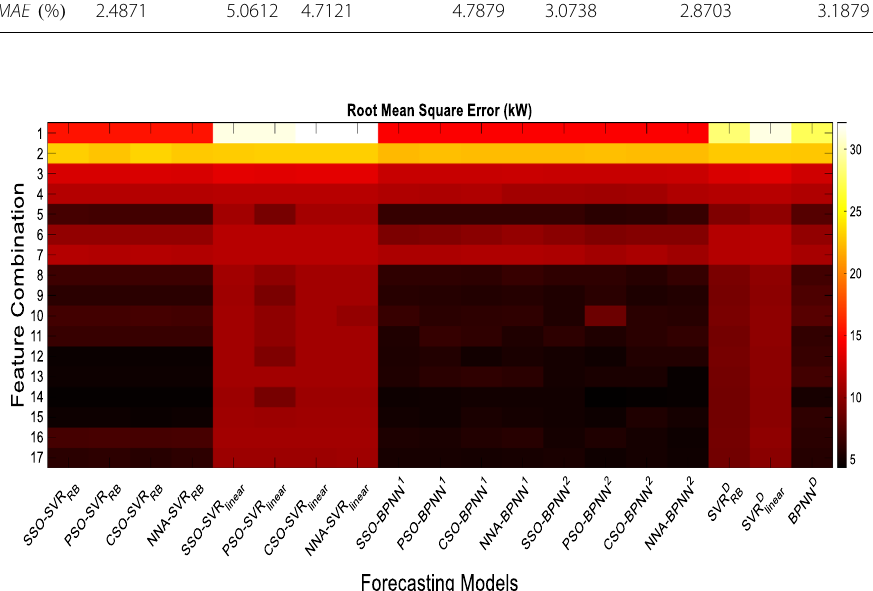
Fig. 8 RMSE values of the study models with the considered feature